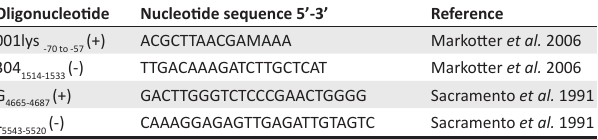
TABLE 3: Oligonucleotide primers used in the study showing annealing positions and nucleotide sequences.